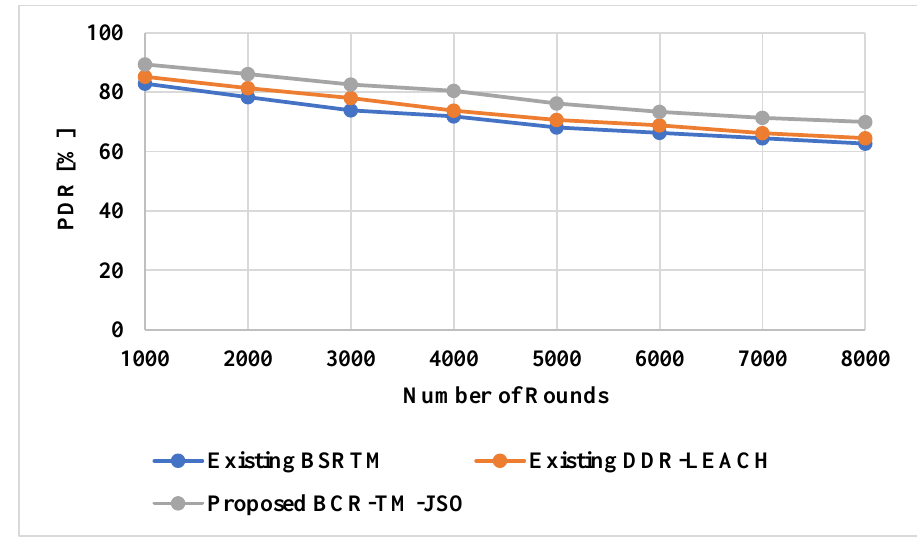
Figure 13. Performance of PDR with existing methods [21, 25].